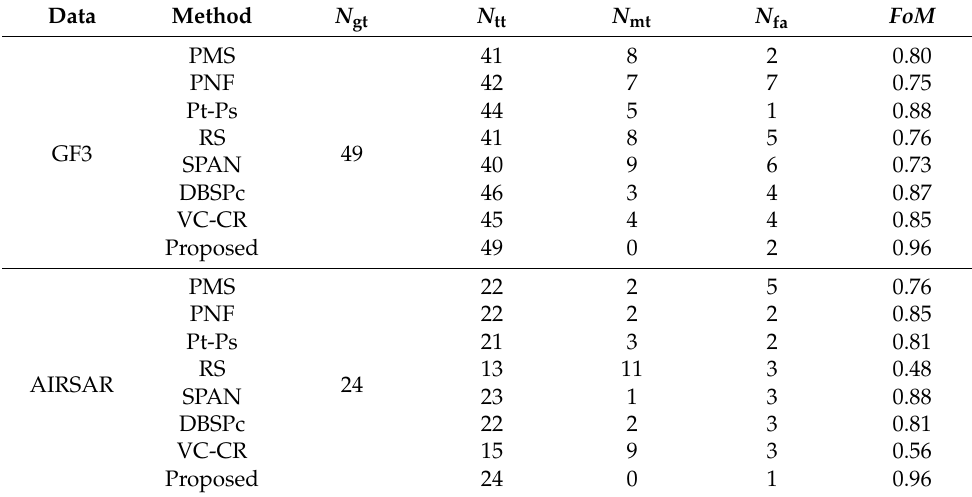
Table 1. Quantitative Evaluations of Different Methods.